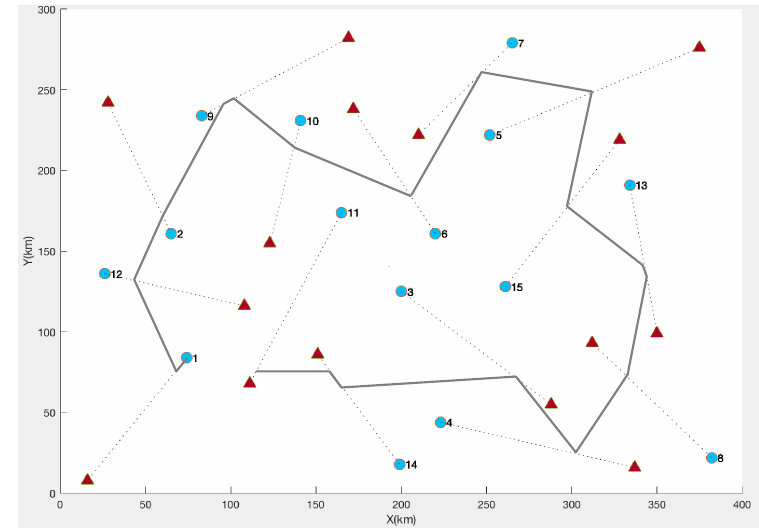
Figure 8. The optimal travel route generated by the Ptr-nets+AC algorithm. (2)